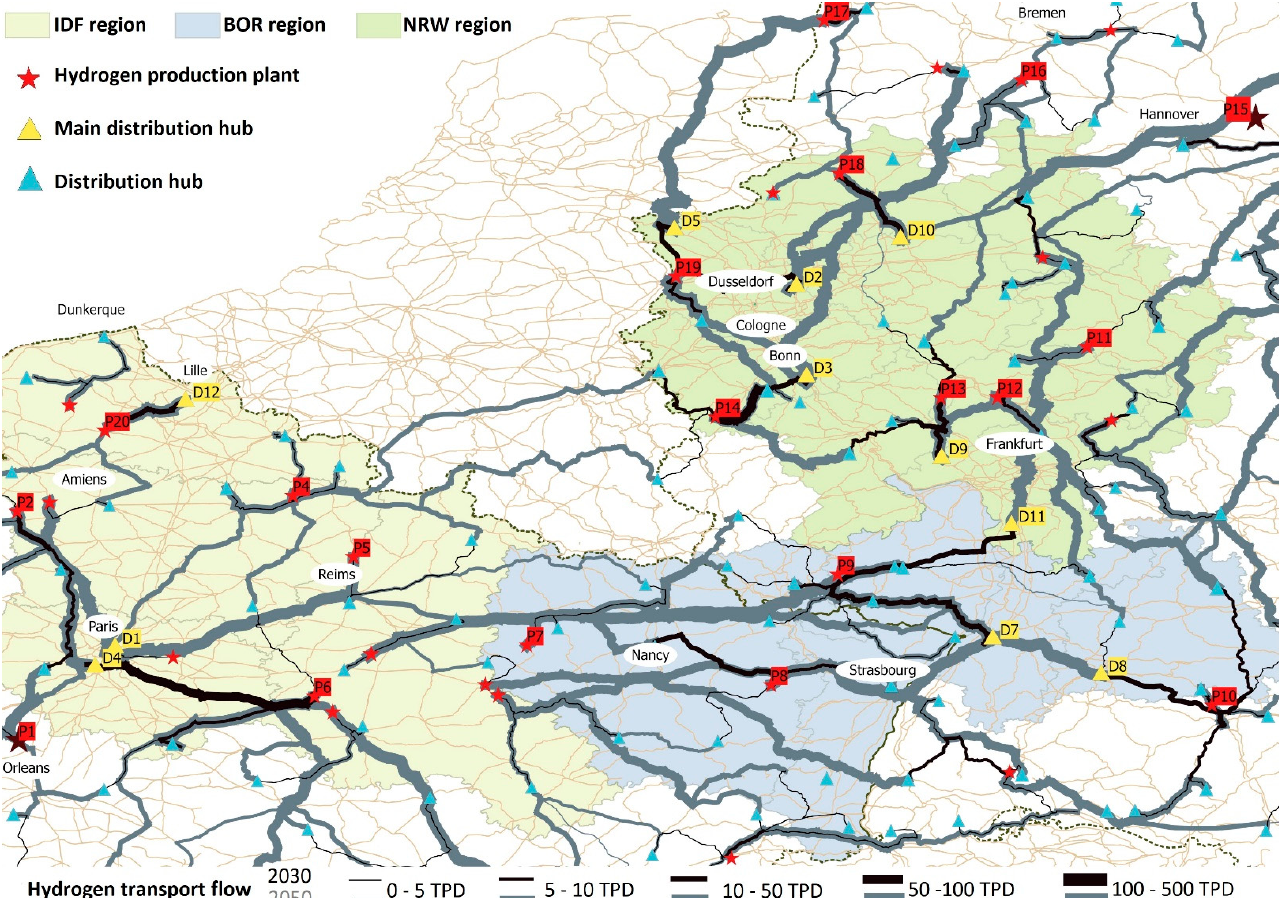
Figure 3. Hydrogen transported in (cid:1845) (cid:2869) and (cid:1845) (cid:2870) at high demand